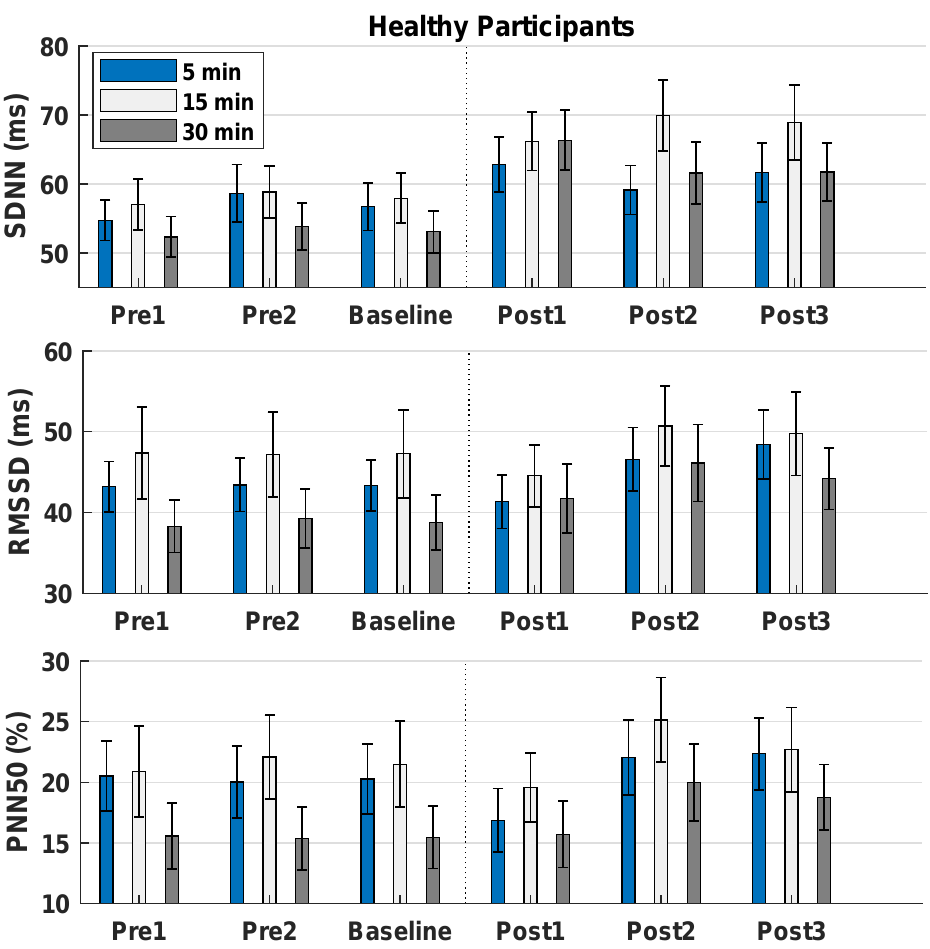
Figure 1. Bar chart showing the heart rate variability-parameters plotted as mean ± standard error in healthy participants. SDNN: The standard deviation of the R-R intervals. RMSSD: The root mean square of successive R-R intervals. PNN50: The proportion of NN50 (pairs of successive R-R intervals that differ more than 50 milliseconds) divided by the total number of R-R intervals. Post1, post2, and post3 were performed at 0–5, 12.5–17.5, and 25–30 min after the deep breathing intervention,